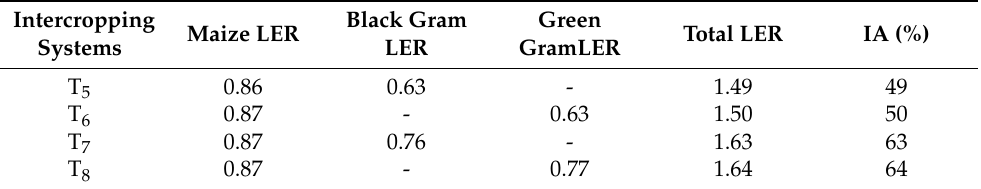
Table 5. Land equivalent ratio (LER) of maize, green gram and black gram as affected by maize-pulses intercropping systems under semi-arid conditions. (Means of 2-years